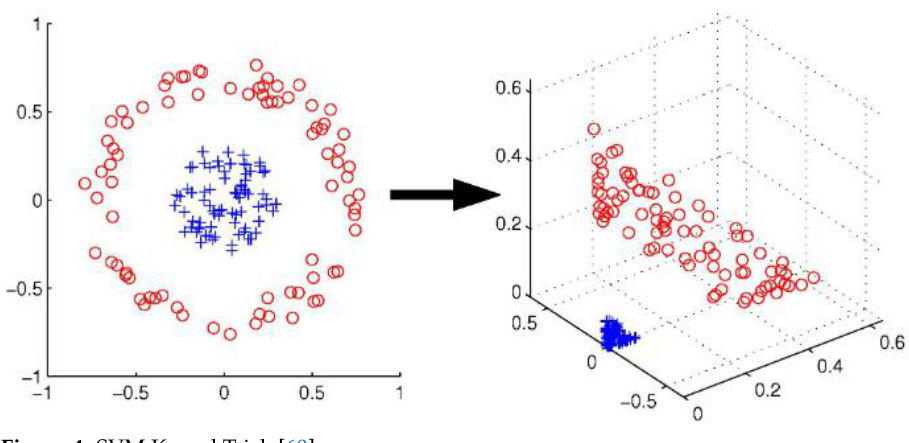
Figure 4. SVM Kernel Trick [60].